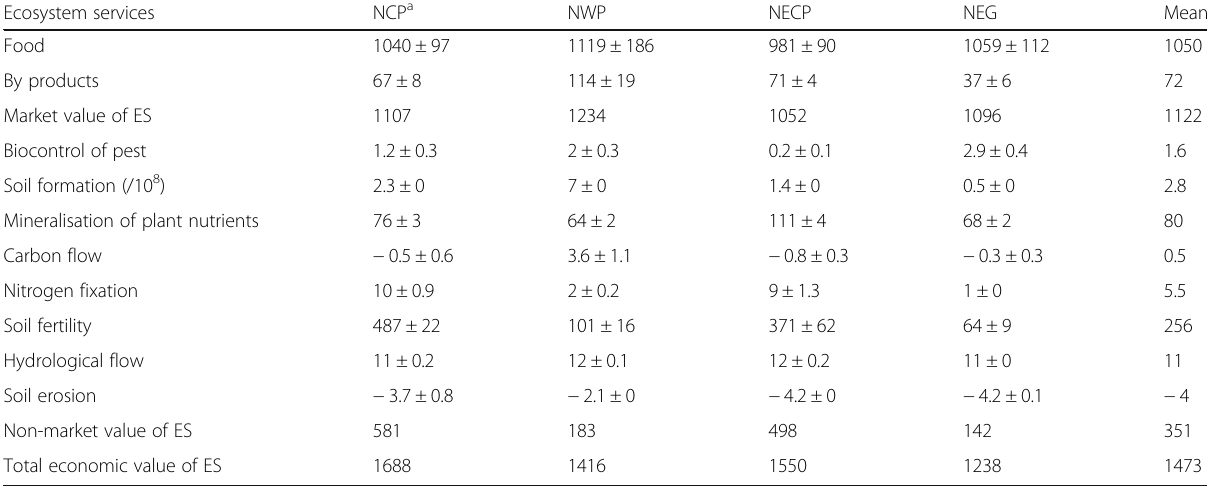
Table 3 Values of ecosystem service (in $ ha − 1 year − 1 ) generated in rice cultivated field under different agro-climatic zones Ecosystem services NCP